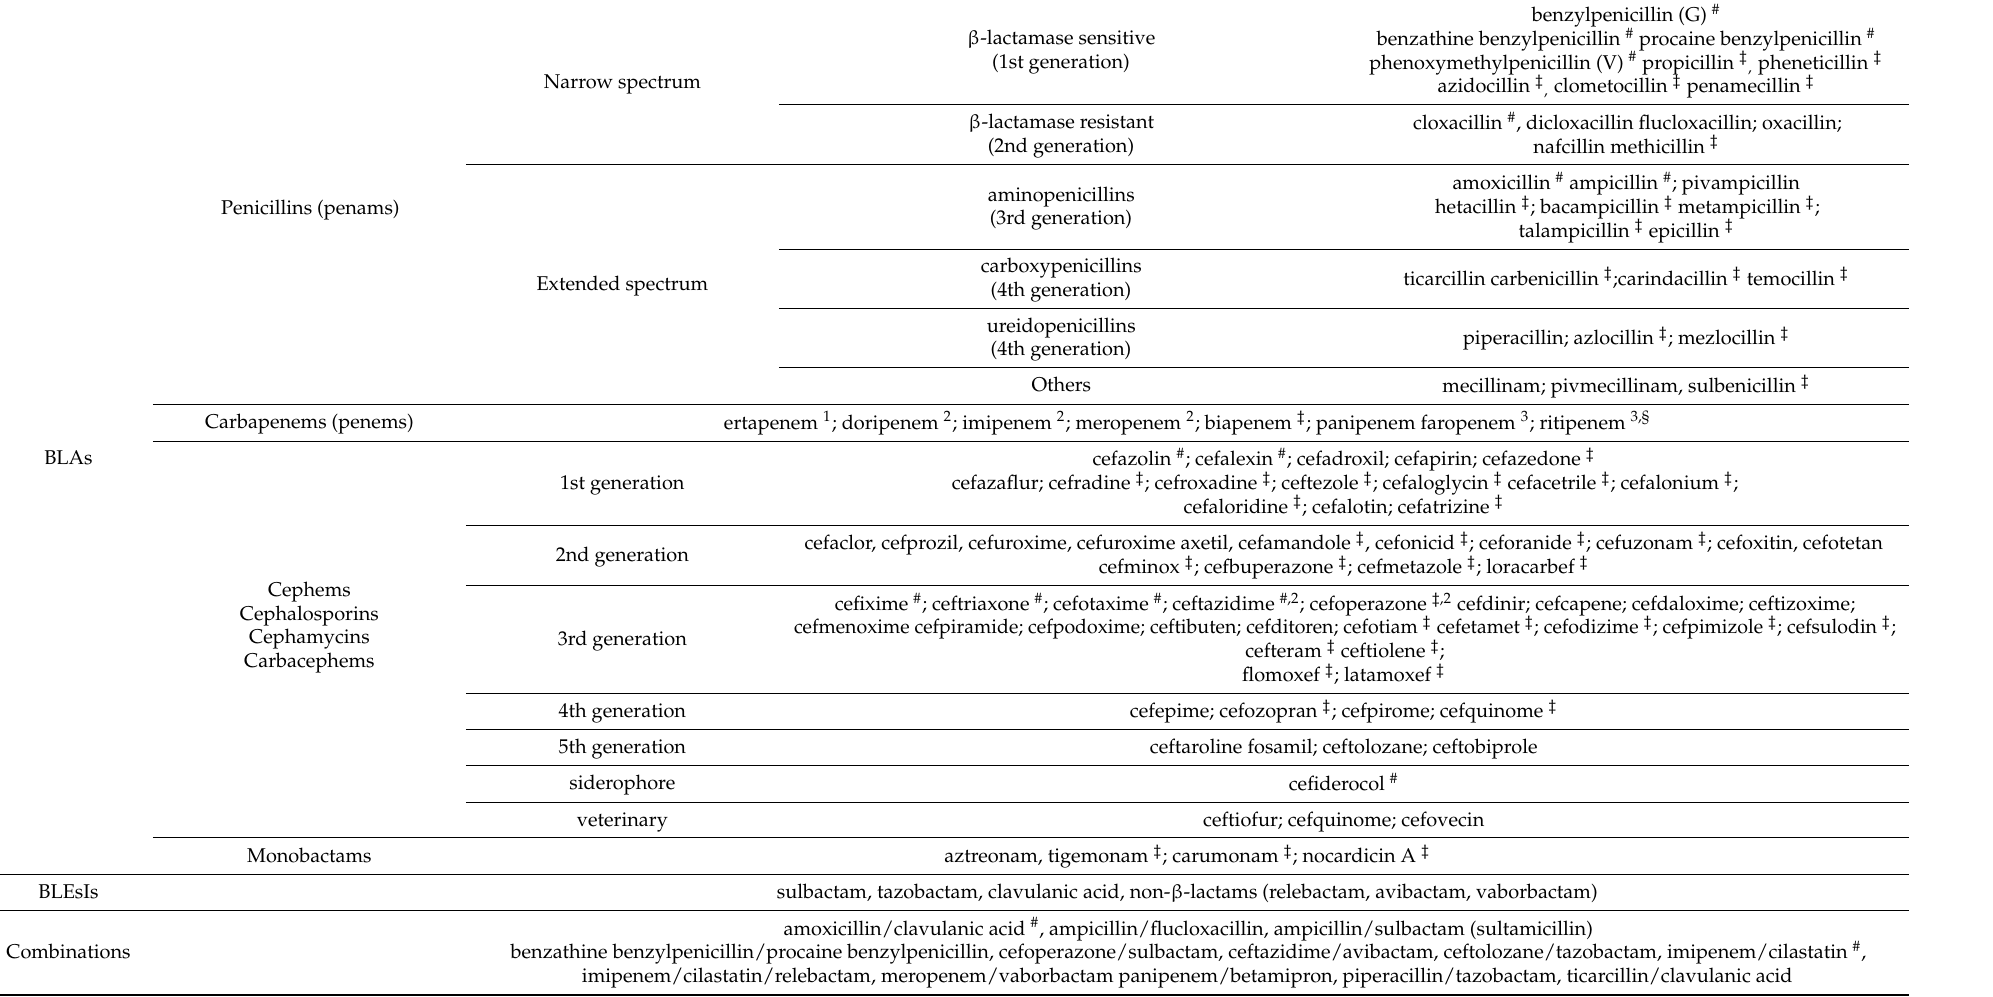
Table 1. Main BLAs classified for type of β -lactam ring, generation, and spectrum of action. Main BLEsIs, and the most common associations